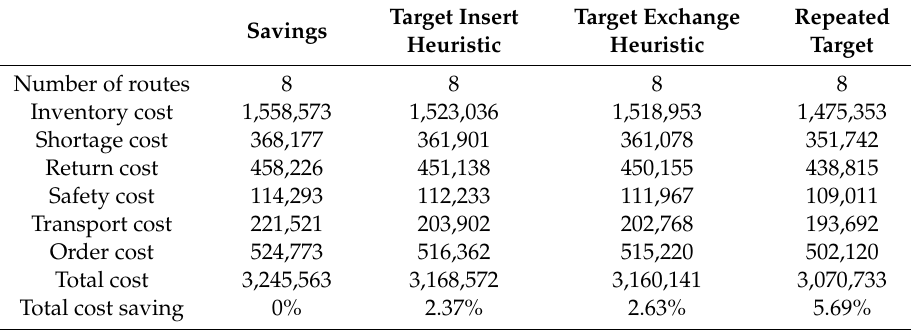
Table 2. The simulated numerical results for ROPIRPSDR.